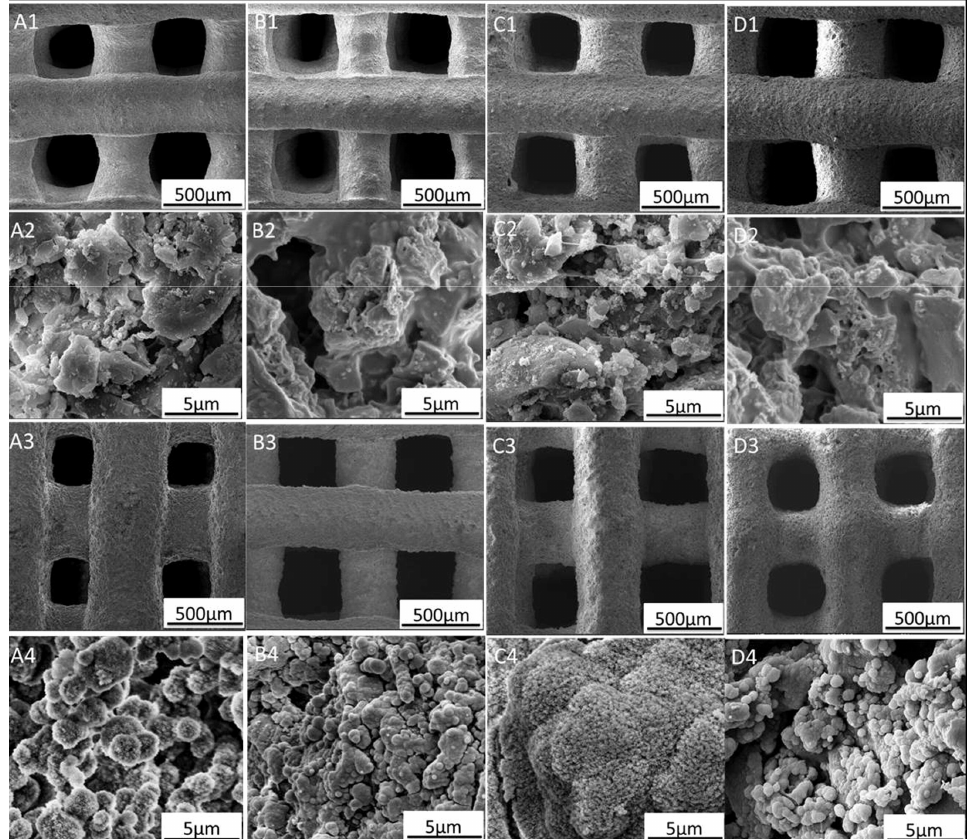
Figure 5. SEM morphology for PVA-Sr-containing bioactive glass scaffolds before and after 3 days of immersion in SBF: ( A1 , A2 ) MBG, ( B1 , B2 ) 5Sr-MBG, ( C1 , C2 ) 10Sr-MBG, and ( D1 , D2 ) 20Sr-MBG. Composition scaffolds before soaking in SBF: ( A3 , A4 ) MBG, ( B3 , B4 ) 5Sr-MBG, ( C3 , C4 ) 10Sr-MBG, and ( D3 , D4 ) 20Sr-MBG after soaking in SBF for 3 days. (Reproduced with permission from [73] Copyright 2014,